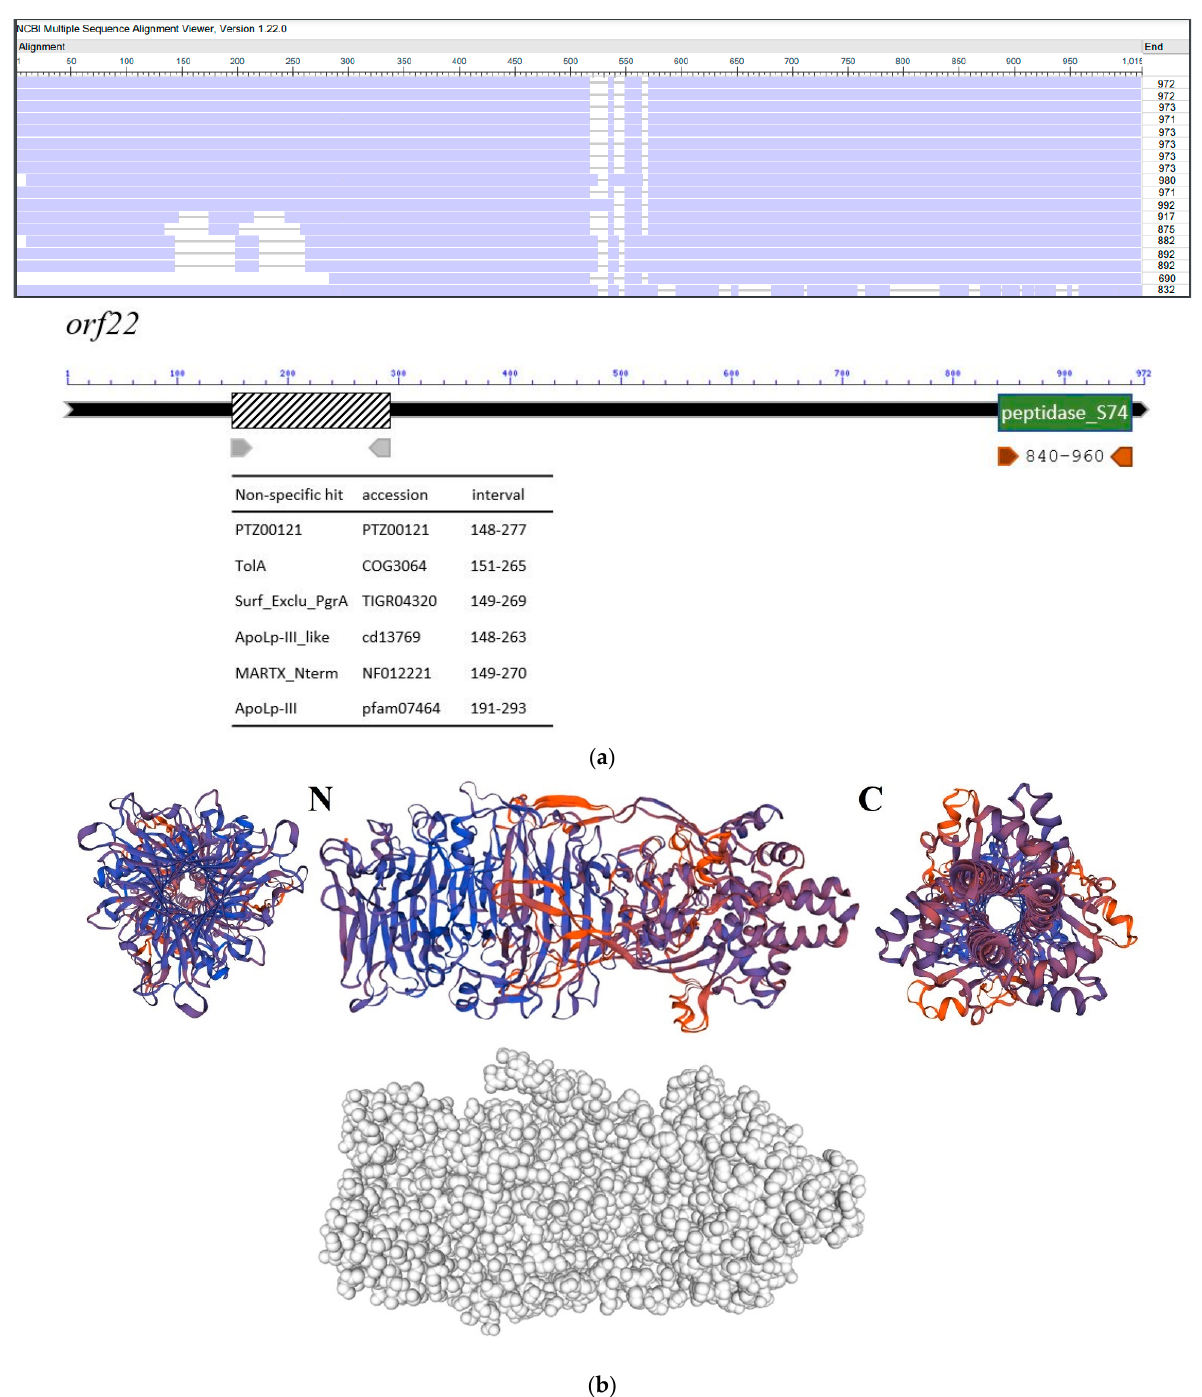
Figure 5. Molecular properties of the tail fiber protein coded by orf22 of phage 731. ( a ) Comparison of homologous proteins of related phages by NCBI COBALT, the order of the phage proteins was originally aligned by Jalview and is the following from the top: 731, GML-KpCol1, vB_KpnS-VAC4, vB_KpnS-VAC7, vB_Kpn-VAC111, vB_KpnS_15-38_KLPPOU149, pK8, MezzoGao, vB_KpnD_PeteCarol, PhiKpNIH-10, NJS2, NJS1, Sweeny, vB_KpnS_Domnhall, vB_KpnS_KingDDD, vB_KpnS_SegesCirculi, PWKp14, Sushi. Pages are detailed in Table 2. Conserved regions of orf22 - coded tail fiber protein of phage 731 are shown below, generated by NCBI BLASTp. ( b ) 3D model of orf22 -coded tail fiber protein by SWISS-MODEL: ribbon model of the trimerized protein viewed from the N-terminal ( left ), side ( middle ), C-terminal ( right ), and space-filling model ( bottom